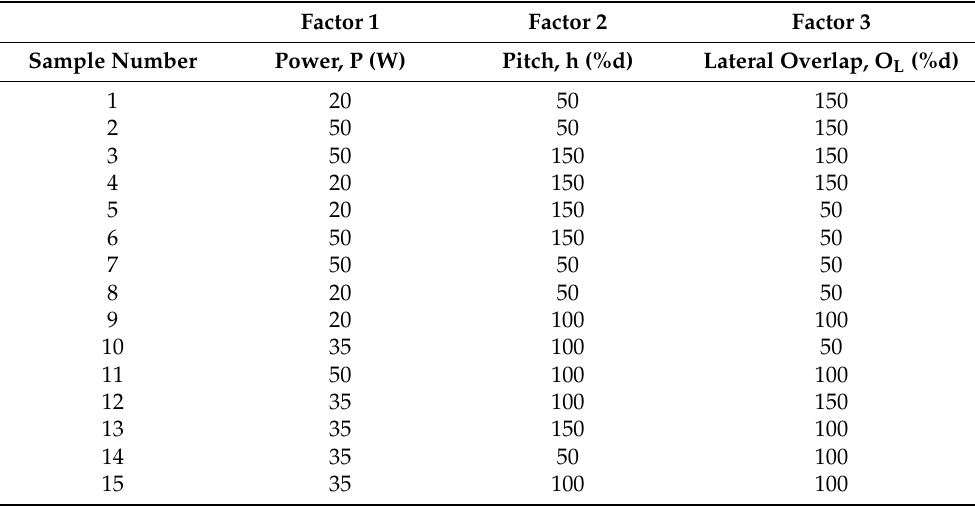
Table 4. Process set-ups experimented with for both